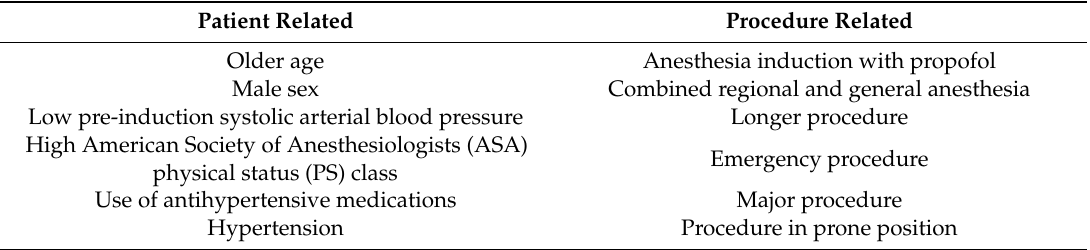
Table 1. Major determinants of intraoperative hypotension